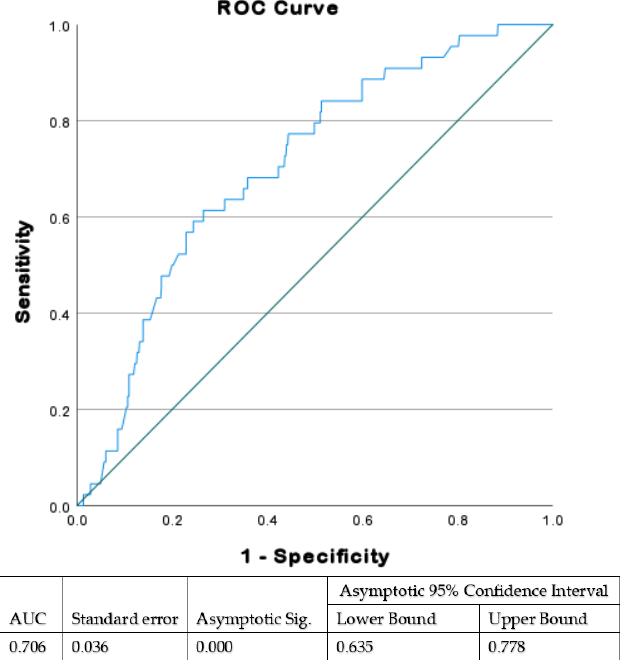
Figure 1. Receiver operating characteristic (ROC) analysis was used to identify a threshold of ultrasonographic EFW (3666 g) that was associated with adverse outcomes after VAD. Adverse outcomes were defined as shoulder dystocia, clavicular fracture, or third- and fourth-degree perineal tear. AUC, area under the curve.